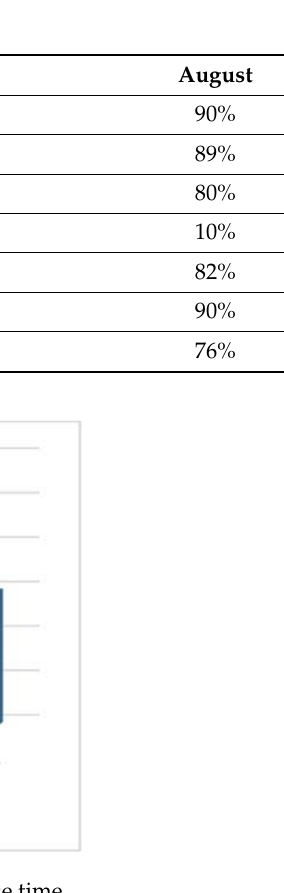
Figure 13. Comparison of proposed and existing method response